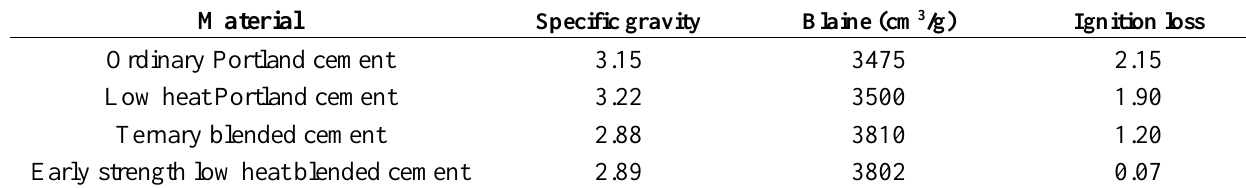
Table 2. Properties of the